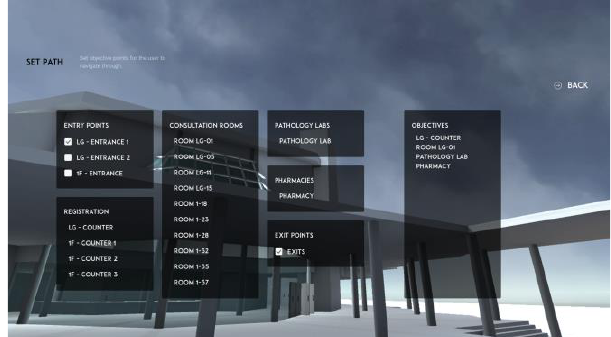
Buildings 2022 , 12 , x FOR PEER REVIEW Figure 3. The wayfinding experiment ’ s user interface used by the investigator to set up the paths . Figure 3. The wayfinding experiment’s user interface used by the investigator to set up the paths.